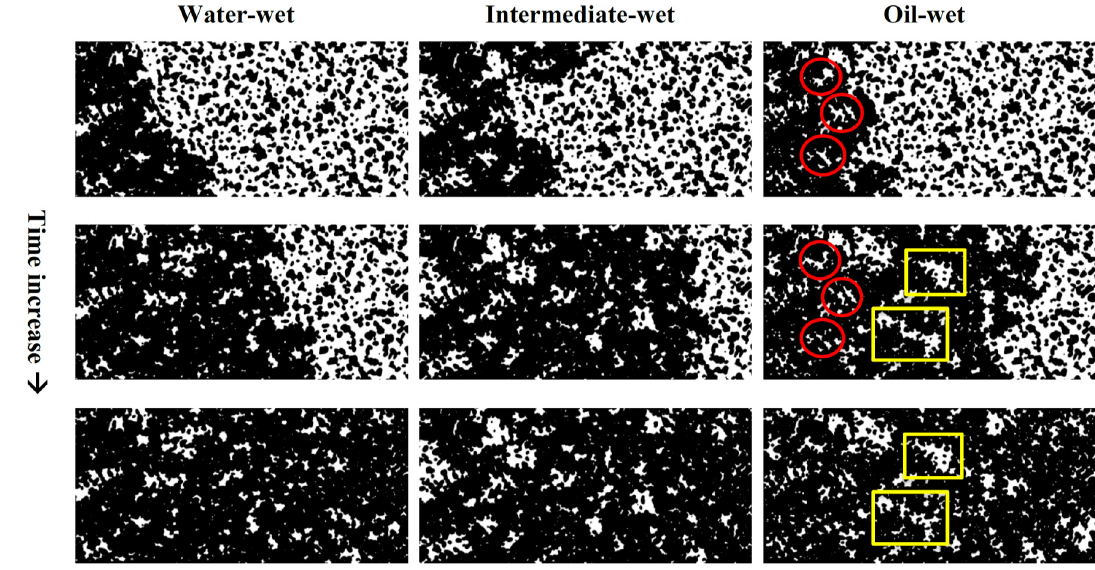
Figure 5. Displacement of the oil by the brine (oil: white; glass and water: black); red circles and yellow boxes show the changes in the oil due to invasion of the unswept areas behind the displacement front, which was only a feature of the oil-wet medium.